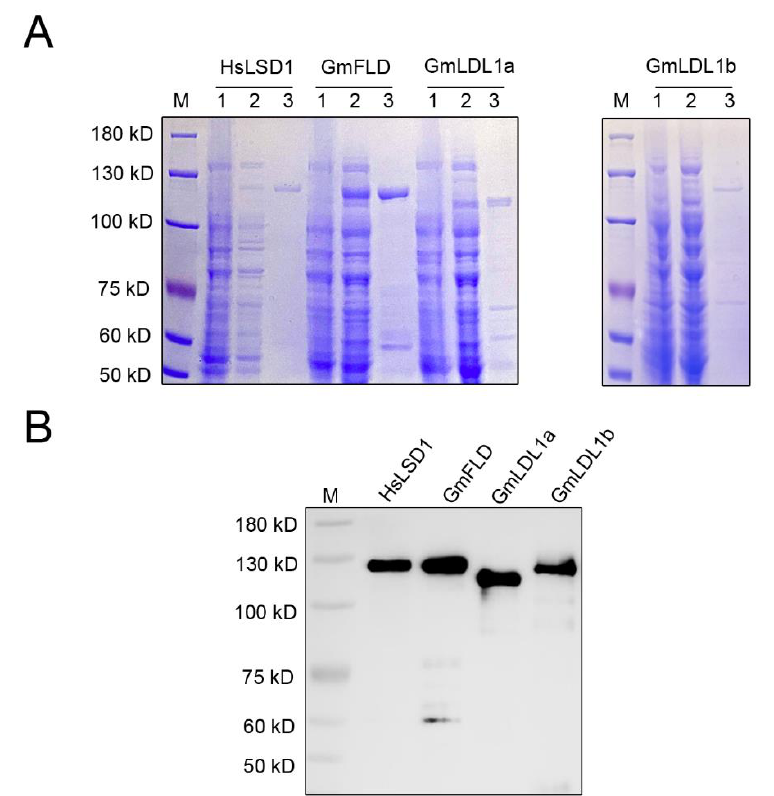
Figure 5. Purification of recombinant GmLDLs expressed in bacteria. ( A ) A SDS-PAGE analysis of the purified recombinant proteins. M, molecular mass marker; 1, total protein of E. coli cell before induction; 2, crude E. coli cell extracts; 3, pooled elution fractions from Glutathione Sepharose 4B resin. ( B ) Immunoblotting of the purified recombinant proteins using an α -GST antibody.